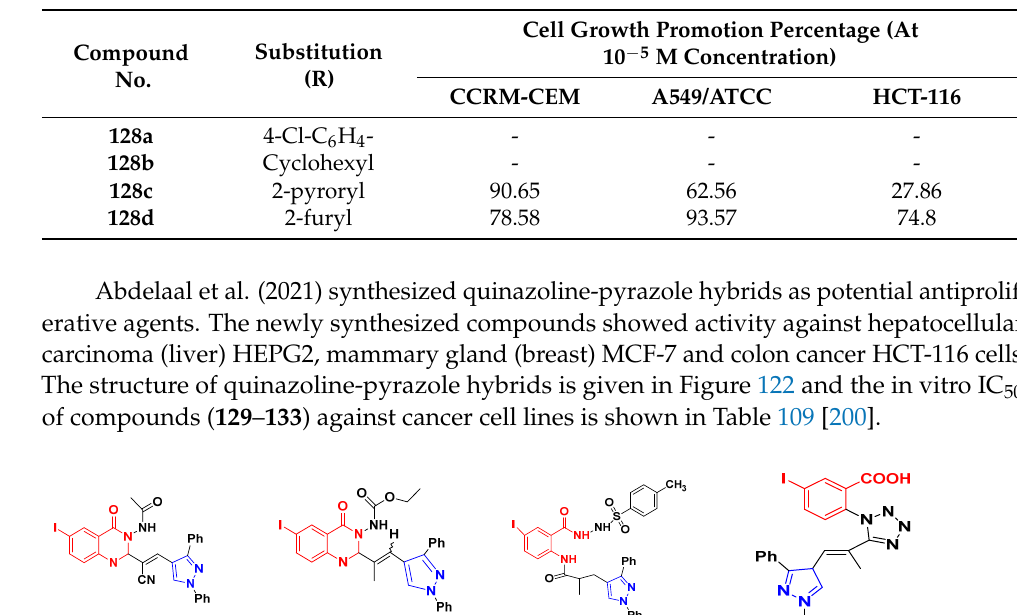
Table 108. In vitro cytotoxic activities of benzofuran-pyrazole-based hybrid compounds 128 ( a – d ). Compound